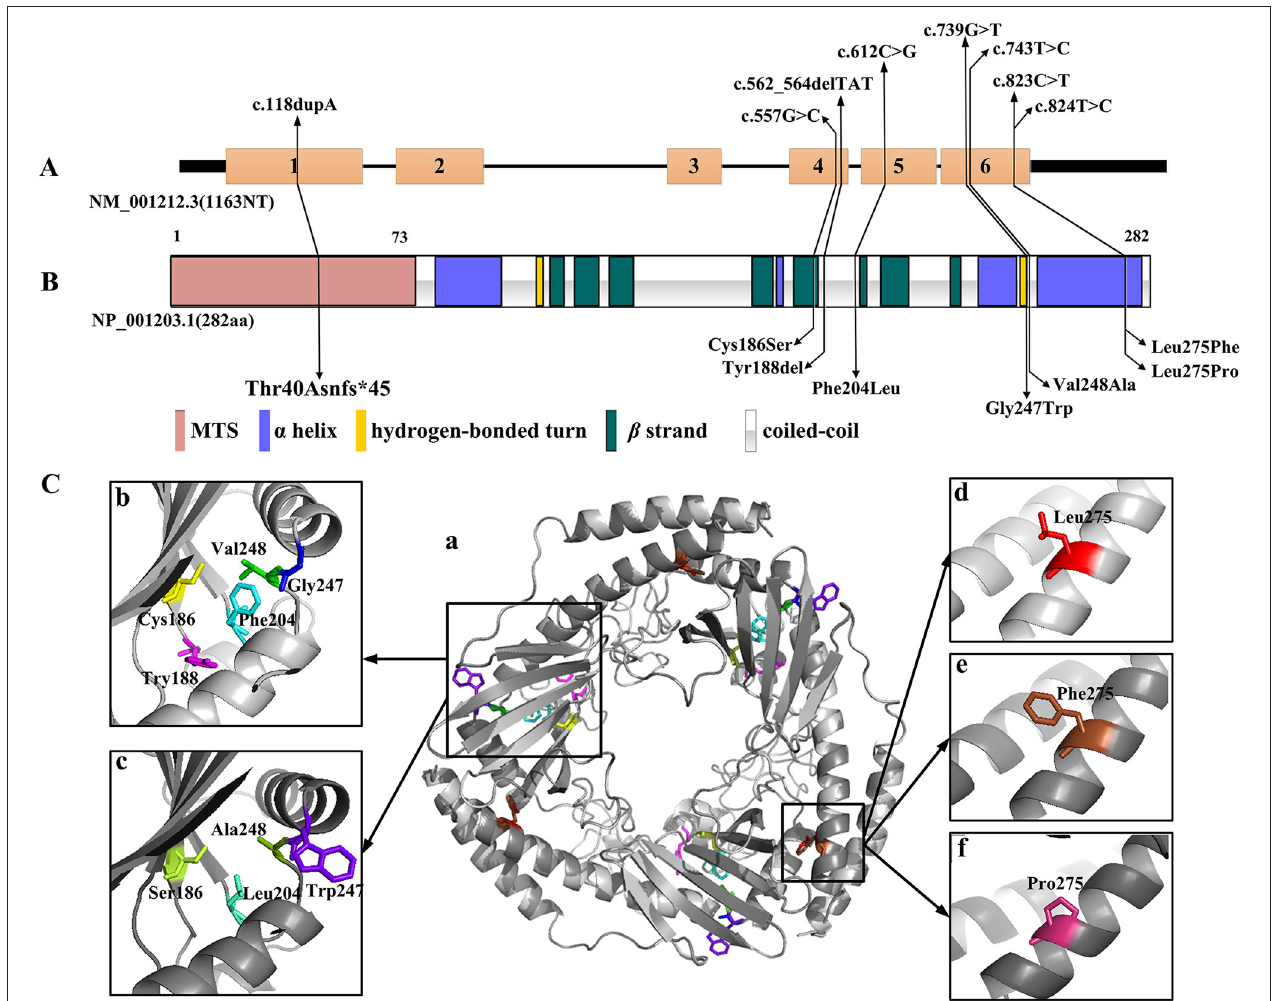
FIGURE 1 | C1QBP variants in gene and protein structure. (A) Gene structure with exons and introns showing the localization of the variants. (B) Secondary structure of the C1QBP indicating the positions of the variants. MTS indicates the mitochondrial target sequence. (C) Inspection of the C1QBP structure performed using PyMOL (PDB accession codes 1P32, https://www.rcsb.org/structure/1P32). a: Predicted three-dimensional structure of the C1QBP protein; b and d: wild type; c, e and f: mutation type. Residue changes are colored in the structure: Cys186, yellow; Ser186, lemon; Tyr188, magenta; Phe204, cyan; Leu204, green-cyan; Gly247, blue; Trp247, purple-blue; Val248, green; Ala248, forest; Leu275, red; Phe275, brown; Pro275, warm pink.